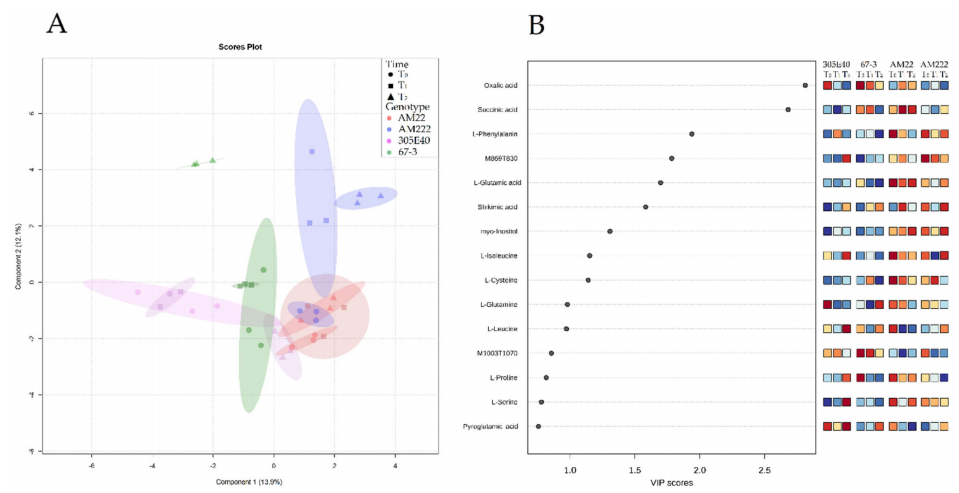
Figure 2. Partial least-squares discriminant analysis (PLS-DA) in shoot. ( A ) 2D scores plot of PLS-DA; the dots represent accessions with 95% confidence regions as ellipses. ( B ) The importance measures used in PLS-DA are VIP scores (variable importance in projection). The colored boxes on the right indicate the relative concentrations of the corresponding metabolite in each